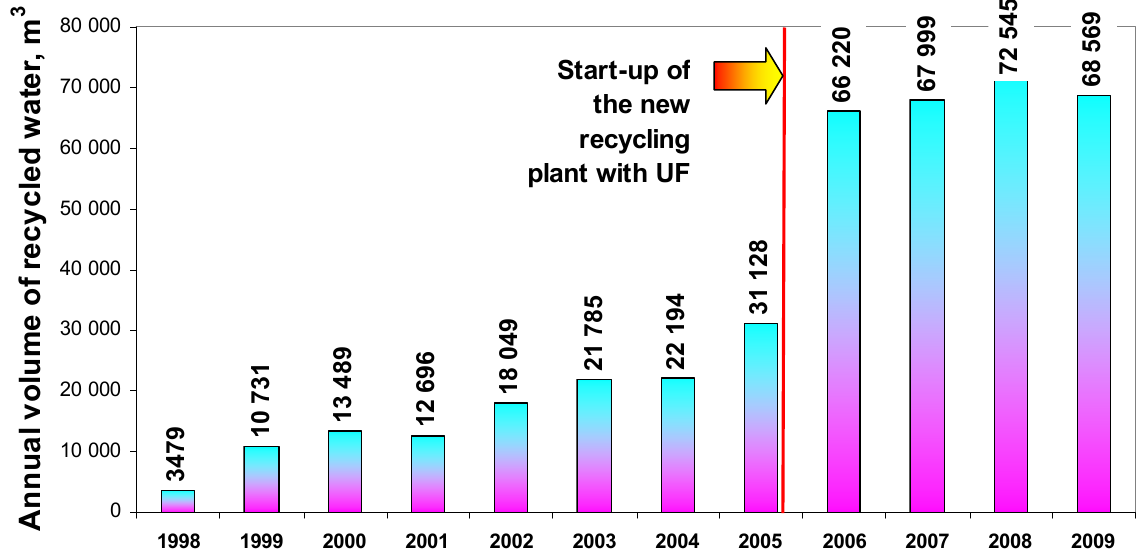
Figure 5. Evolution of the recycled water demand in Bora Bora.